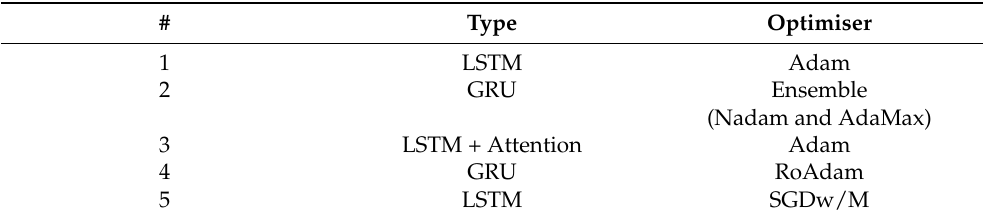
Table 2. Five ML models were tested. Type highlights the RNN structure used in the cells. Optimiser was based on the derivative calculation algorithms only.